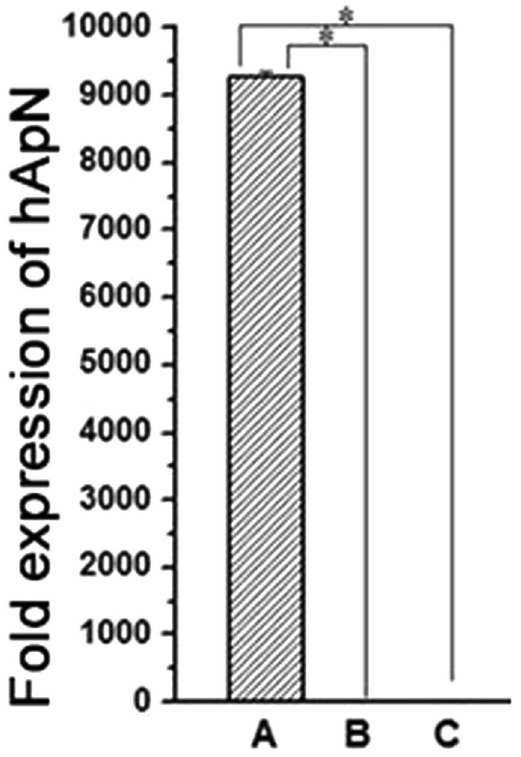
Figure 3. Gene expression of hAPN in BMSCs. High expression of hAPN in group A (Ad-hAPN-EGFP) and no expression in group B (Ad-EGFP) and group C (blank control). * P <